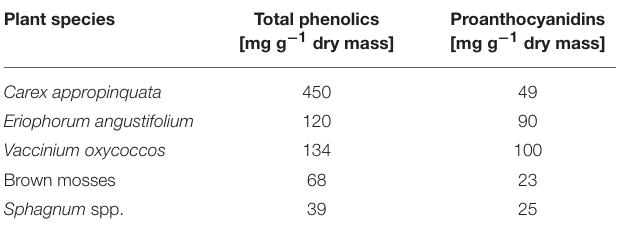
FIGURE 9 | Significant linear relationships between microbial activity and other measured variables. The microbial activity was determined as enzyme activity using fluorescein diacetate (FDA) hydrolysis. Values are given on dry mass (DM) basis. The complete variable set (peat chemistry, pore water chemistry, and potentially inhibiting substances) were tested. Only relationships with linear models significant with p < 0.05 are displayed. TABLE 4 | Average contents of total phenolics and proanthocyanidins (median, n = 3) in roots from selected peat-forming vascular plant and from moss litter (for plant sampling sites see section Study sites and